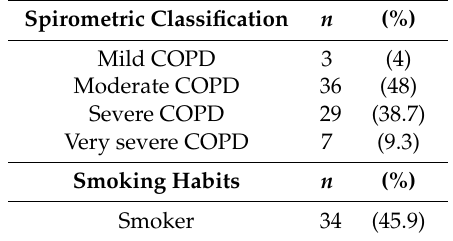
Table 2. Disease